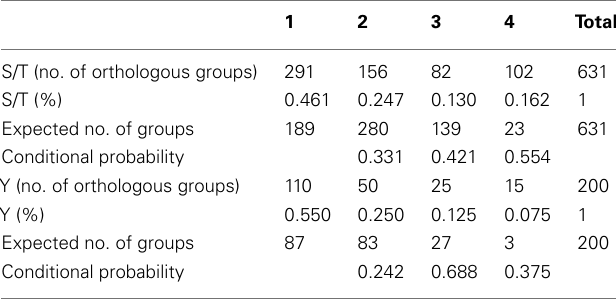
Table 2 | Statistics of S/T andY centered classes.